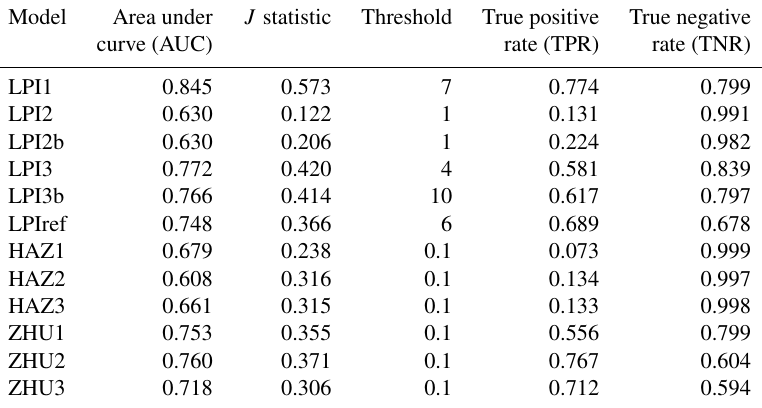
Table 6. Model quality diagnostics and optimum threshold values for each model from ROC curves. Refer to Table 4 for descriptions corresponding to model acronyms.